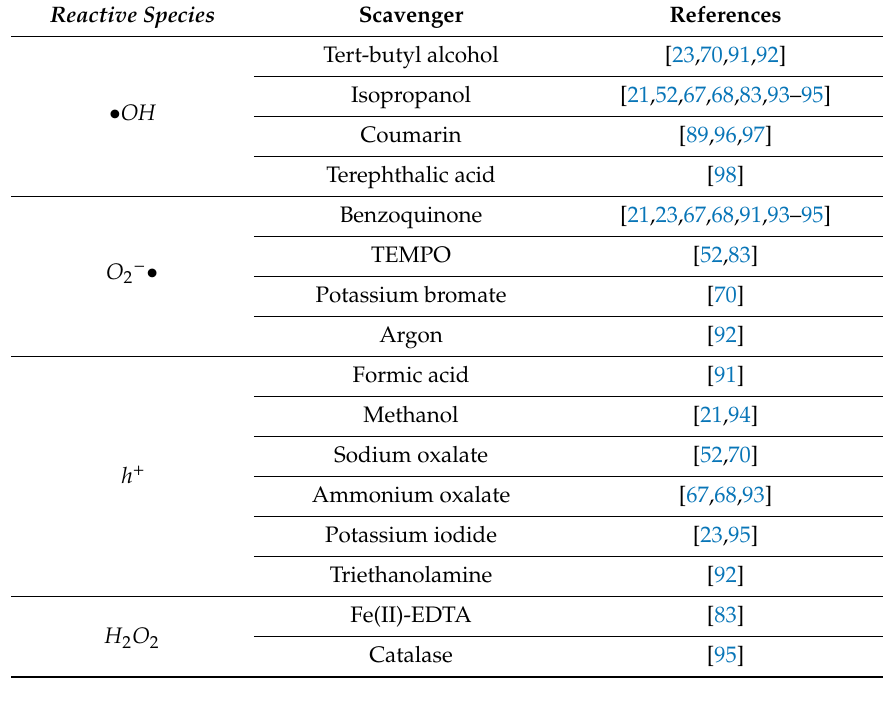
Table 1. Scavengers used in the reviewed articles for each reactive species.